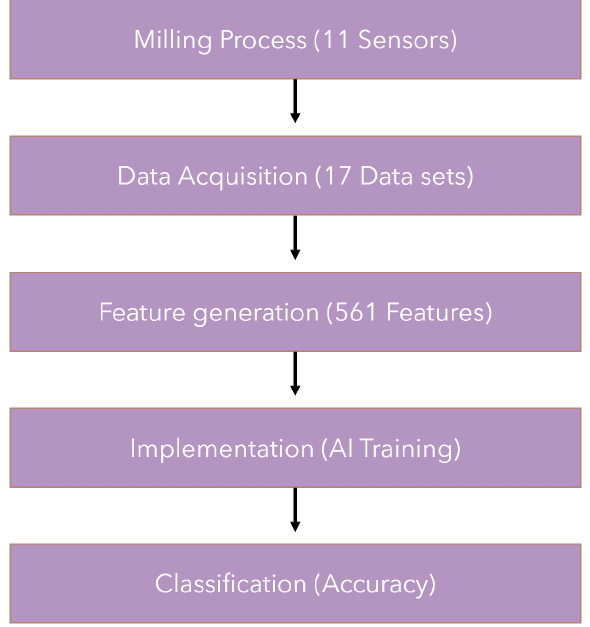
Figure 8. Key steps of the presented